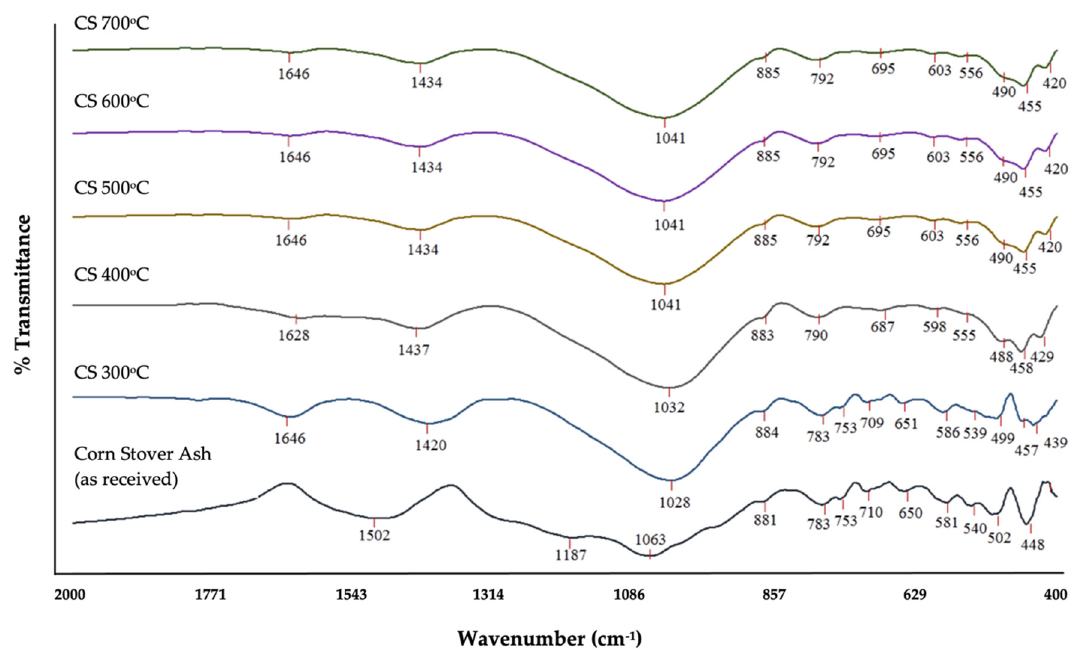
Figure 8. FT-IR spectra of corn stover ash under different calcination temperatures.